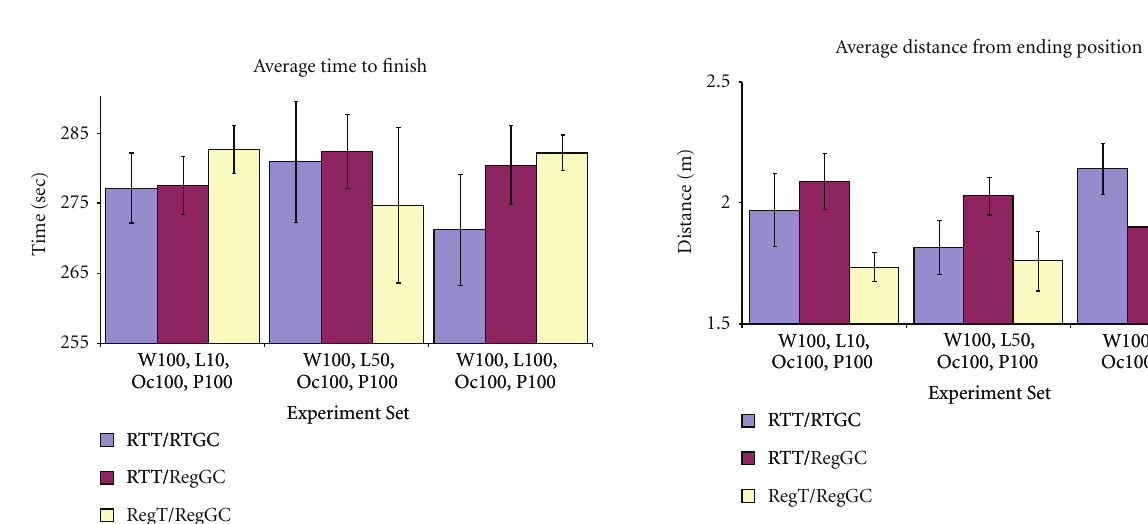
Figure 7: The average distance the robot came to the ending position for group 1.